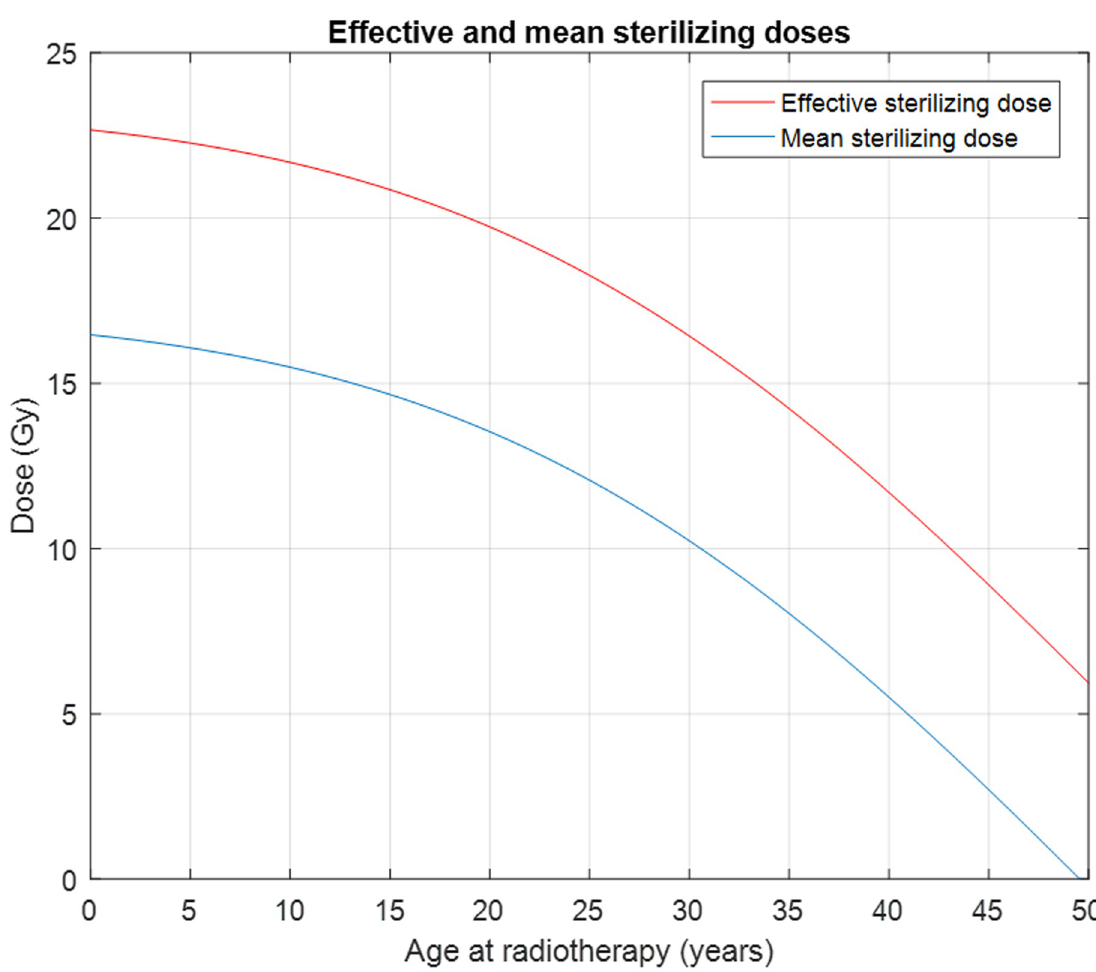
Fig 3. The mean and effective sterilizing doses of radiation to the human ovary. The blue line shows the radiation in Gy needed to sterilize 50% of subjects. The red line shows the radiation in Gy needed to sterilize 97.5% of subjects. The predictions are derived from the Wallace-Kelsey model of NGF population in healthy females [20], and the estimated radio sensitivity of the human NGFs